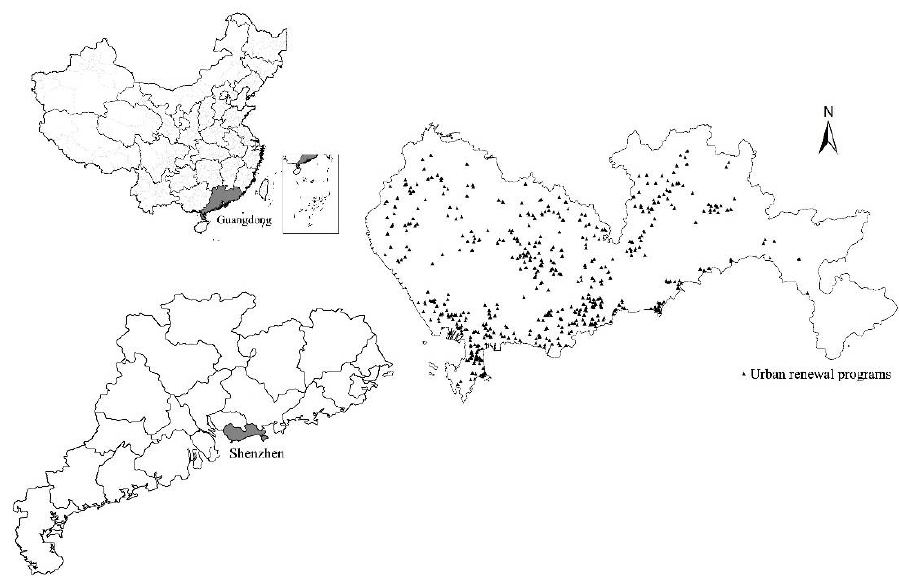
Figure 1. Location of the study area.